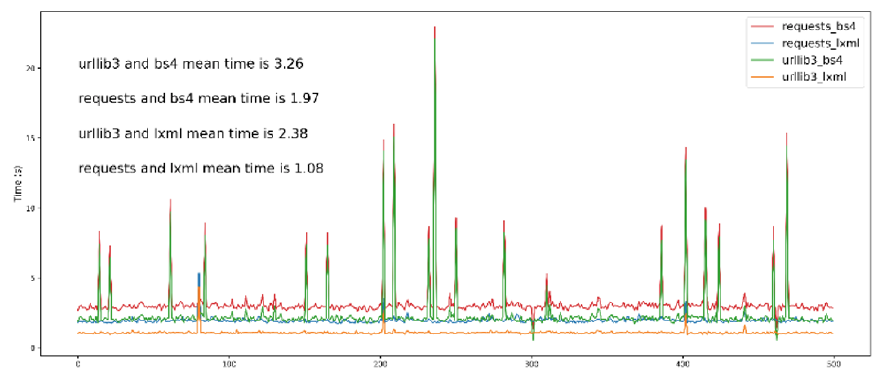
Figure 4. Best web scraping combination.